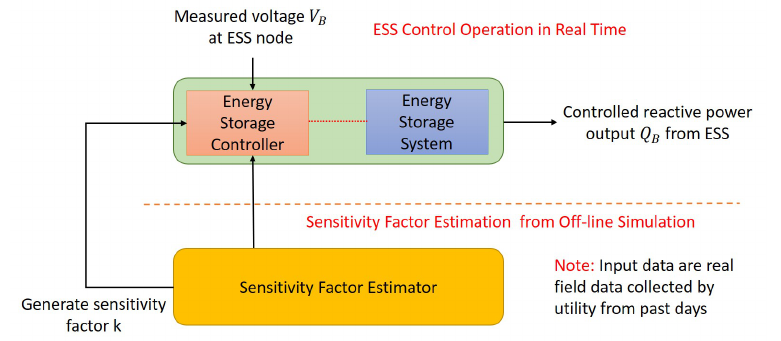
Figure 2. The scheme of the proposed energy storage system (ESS) control